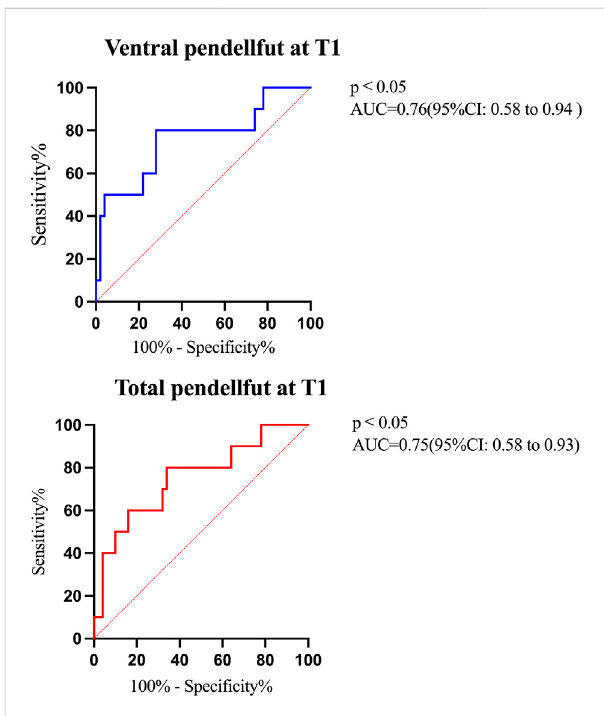
FIGURE 4 Areas under the ROC curves for the pendelluft volume during SBT. Blue line denote ROC for ventral pendelluft at T1 to failure weaning (AUC = 0.76, 95% CI: 0.58 – 0.94, cutoff = 3% of global tidal impedance variation); Red line was ROC for total pendelluft at T1 to predict failure weaning (AUC = 0.75, 95%CI: 0.58 – 0.93, cutoff = 5% of global tidal impedance